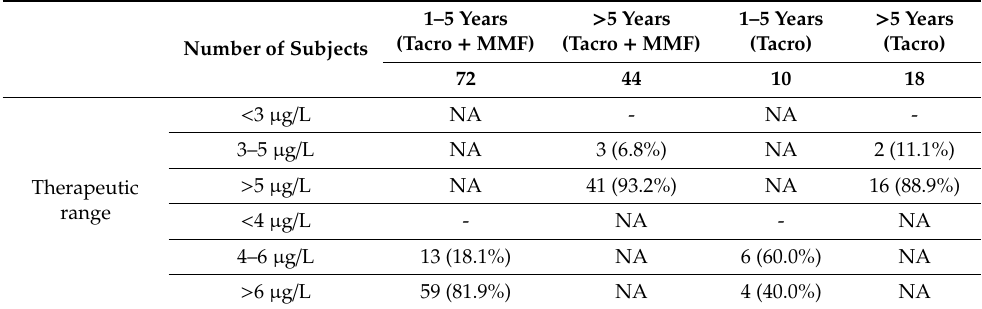
Table 4. Comparative table of Tacro C 0 values’ compliance within therapeutic